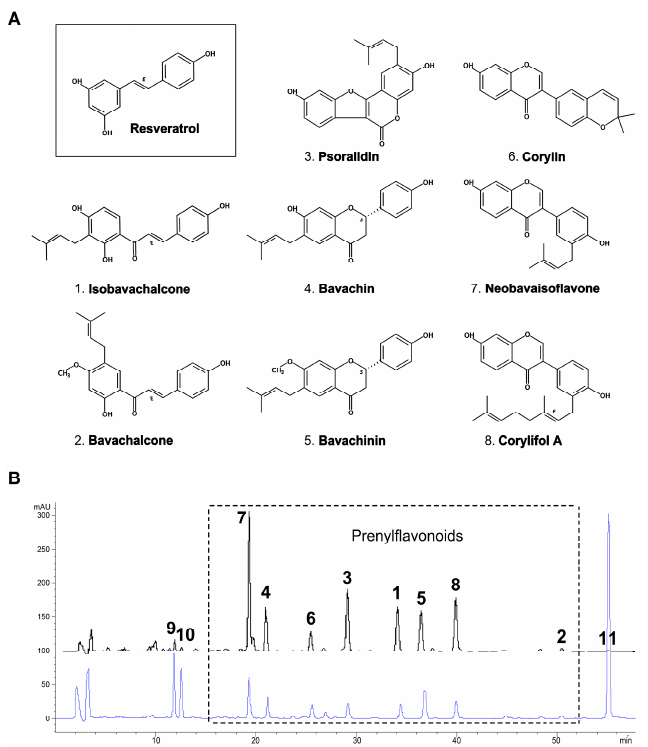
Figure 1. ( A ) Chemical structures of resveratrol and eight major compounds in total prenylflavonoids (TPFB); and ( B ) a representative HPLC chromatograph of TPFB (upper line) in comparison with the methanol extract of Buguzhi (lower line) detected at wavelength 245 nm. Peaks: ( 1 ) Isobavachalcone; ( 2 ) Bavachalcone; ( 3 ) Psoralidin; ( 4 ) Bavachin; ( 5 ) Bavachinin; ( 6 ) Corylin; ( 7 ) Neobavaisoflavone; ( 8 ) Corylifol A; ( 9 ) Psoralen; ( 10 ) Isopsoralen; ( 11 ) Bakuchiol. Note: ( 9 ), ( 10 ) and ( 11 ) are major compounds in Buguzhi but are successfully removed in TPFB.